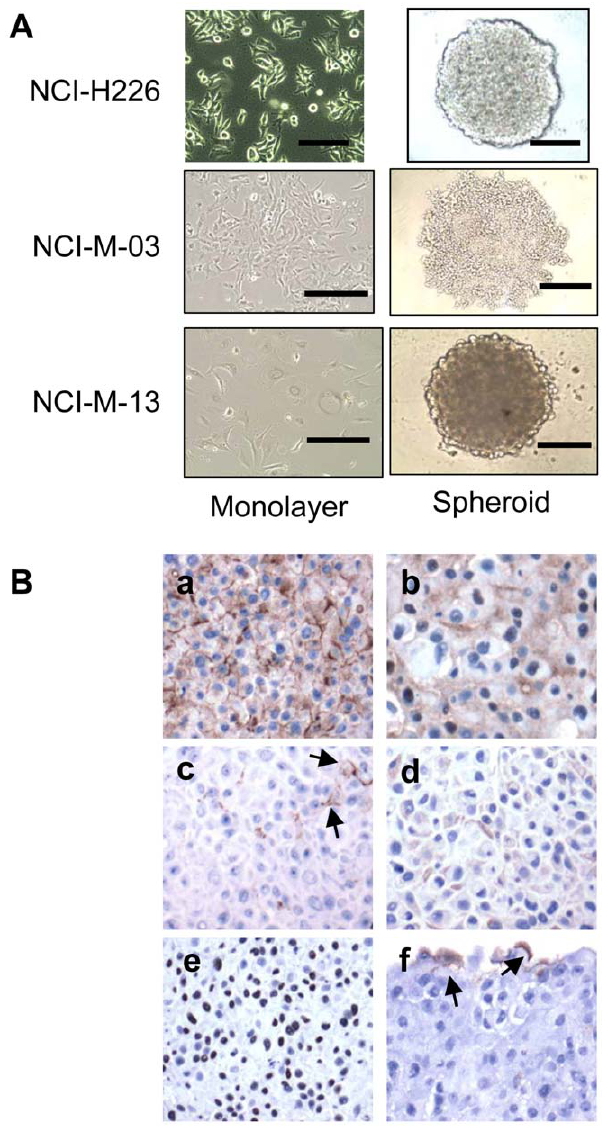
Figure 1. Establishment of human mesothelioma spheroids. A. Monolayers and spheroids of human mesothelioma cell line, NCI-H226, and primary mesothelioma lines NCI-M-03 and NCI-M-13. Scale bars, 400 m m (except 200 m m for NCI-M-13 spheroids). B. Immunohisto- chemical staining of an NCI-H226 spheroid (see Methods ). (a) Mesothelin stains both the membrane and cytoplasm. (b) Calretinin stains both the nuclei and cytoplasm. (c) HBME-1 exhibits a focal membranous staining pattern (arrows). (d) Cytokeratin 5/6 exhibits a focal cytoplasmic staining pattern. (e) WT-1 stains the nuclei. (f) Thrombomodulin exhibits a focal membranous staining pattern close to the rim (arrows).